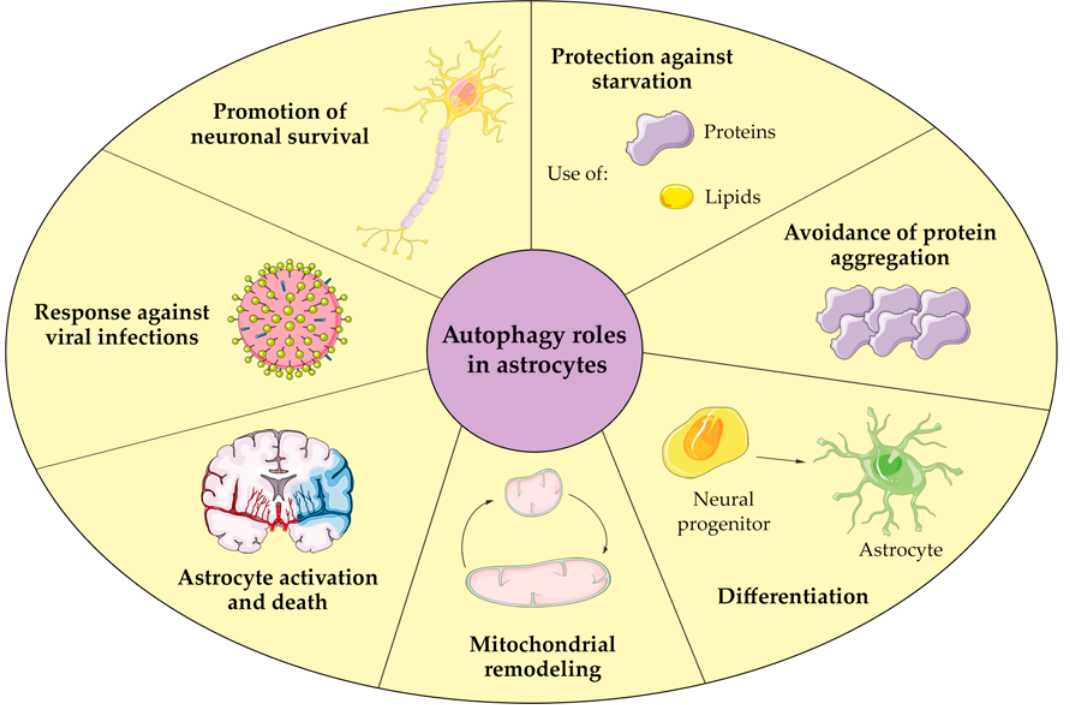
Figure 1. Autophagy functions in astrocytes.